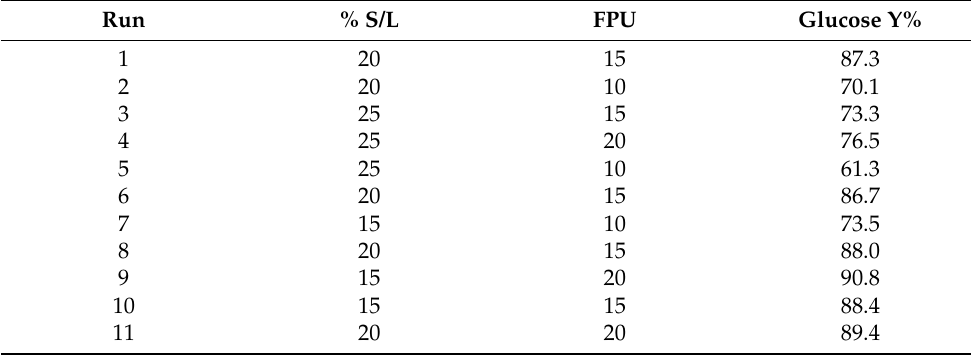
Table 3. Conversion rate of cellulose using different combinations of parameters.